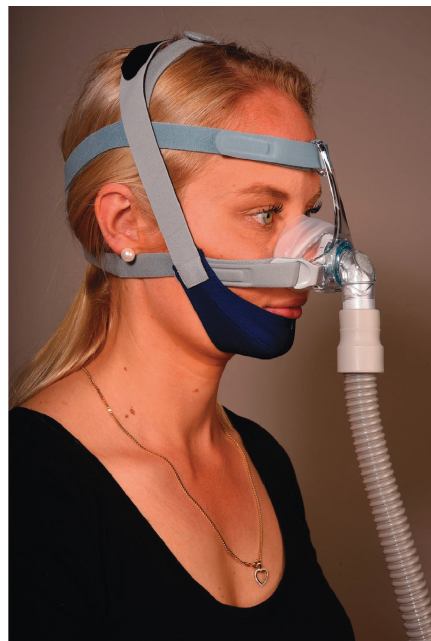
Figure 11: The chinstrap prevents the mouth from opening during CPAP